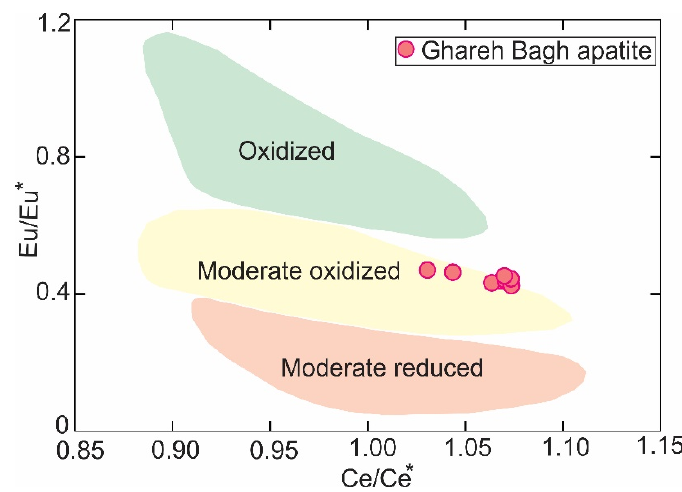
Figure 10. Eu anomalies (Eu / Eu*) vs. Ce anomalies for the apatite samples. Fields from Cao et al. [14]. Ghareh Bagh apatite plot in the moderate oxidized environment.